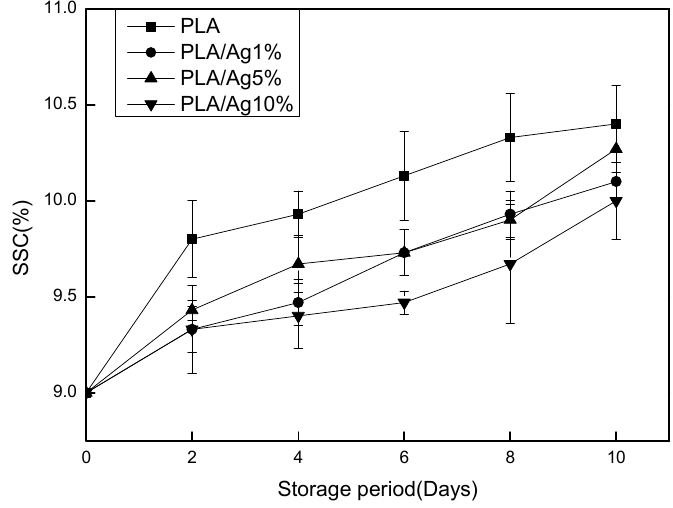
Figure 3. Effect of different concentration of nano-Ag active packages on soluble solid content of strawberry stored at 4 ± 1 °C for 10 days. Data are presented as mean ± standard deviation.